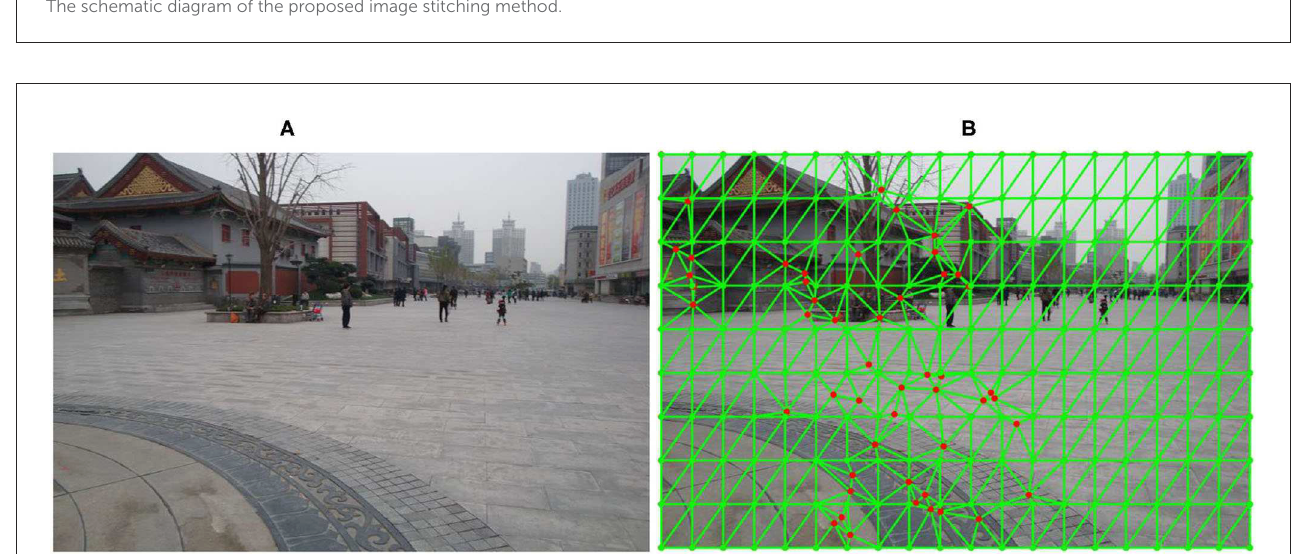
FIGURE2 View triangulation results on the target image. (A) The template image and (B) the triangular mesh image. The green dots are APAP vertices, and the red dots denote matched feature vertices.